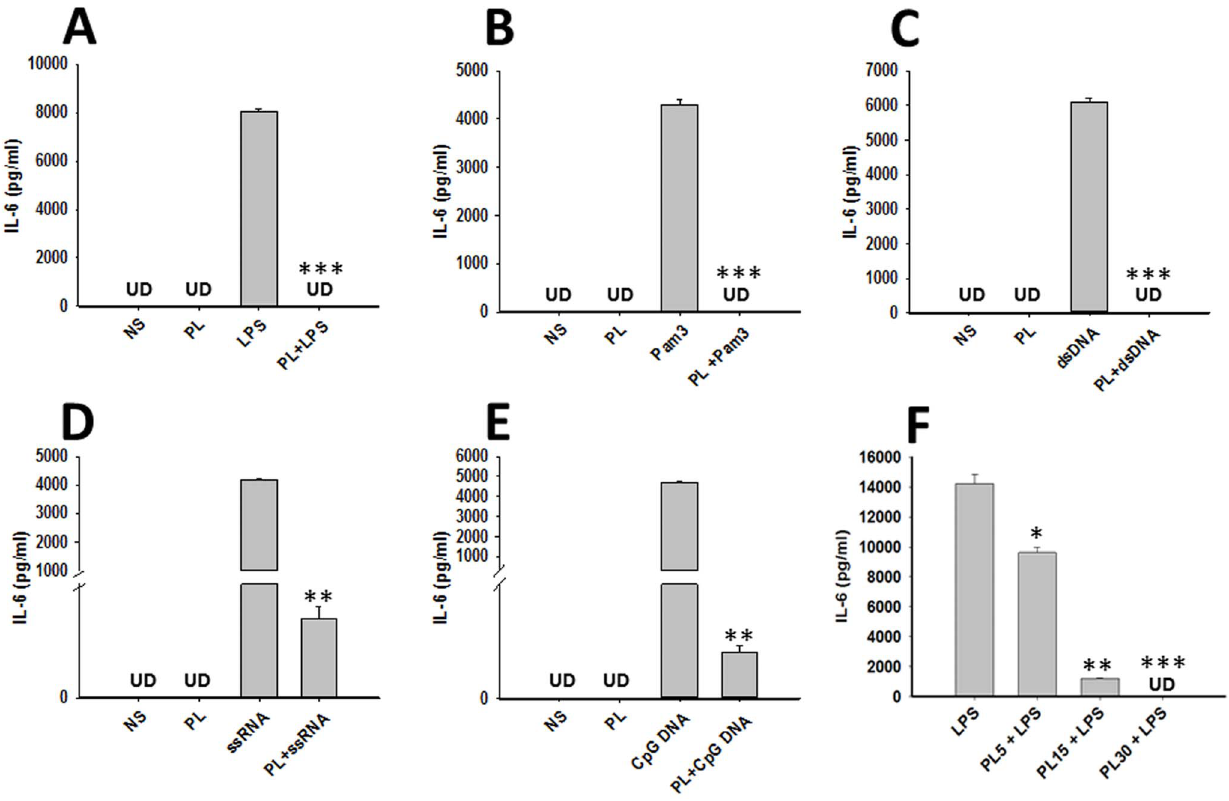
Figure 3. Effect of PL on cytokine production by BMDMs. BMDMs were pulsed with medium alone, PL at 25 ug/ml, or various TLR ligands; LPS (10 ng/ml) ( A ), Pam3 Cys4 (Pam3) at 10 ng/ml ( B ), dsRNA (10 ng/ml) ( C ), ssRNA (10 ng/ml) ( D ), CpG DNA (1 m M) ( E ), or PL before the addition of respective TLR agonists in the medium. Cells were cultured for a total of 24 h period. The cytokine contents of IL-6 and TNF- a in culture supernatants were assayed by using specific sandwich enzyme-linked immunosorbent assays as recommended by the manufacturer (BD biosciences or R&D Systems). Cytokines detected below the assay detection limit for each stimulation are presented as UD (undetected). The mean 6 SE concentration of cytokines in five independent experiments was determined. (F) BMDMs were pulsed with medium alone, PL at various concentrations; 5 ug/ml (PL5), 15 ug/ml (PL15) or 30 ug/ml (PL30), before the addition of LPS (10 ng/ml) in the medium. The cytokine contents of IL-6 in culture supernatants were assayed at 24 h as described above. Significant differences were measured by Student’s t test and are denoted by asterisks (*, P , 0.05, **, P , 0.01 and ***, P , 0.001).